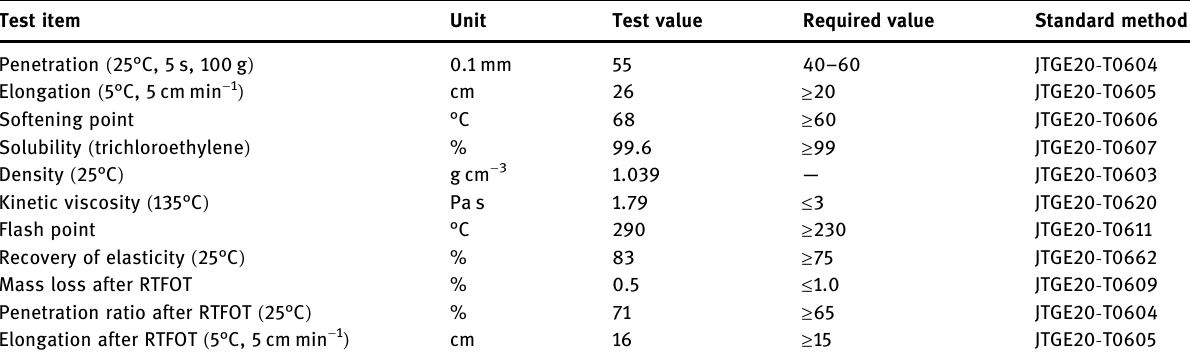
Table 1: Physical properties of the SBS - modi fi ed asphalt binder